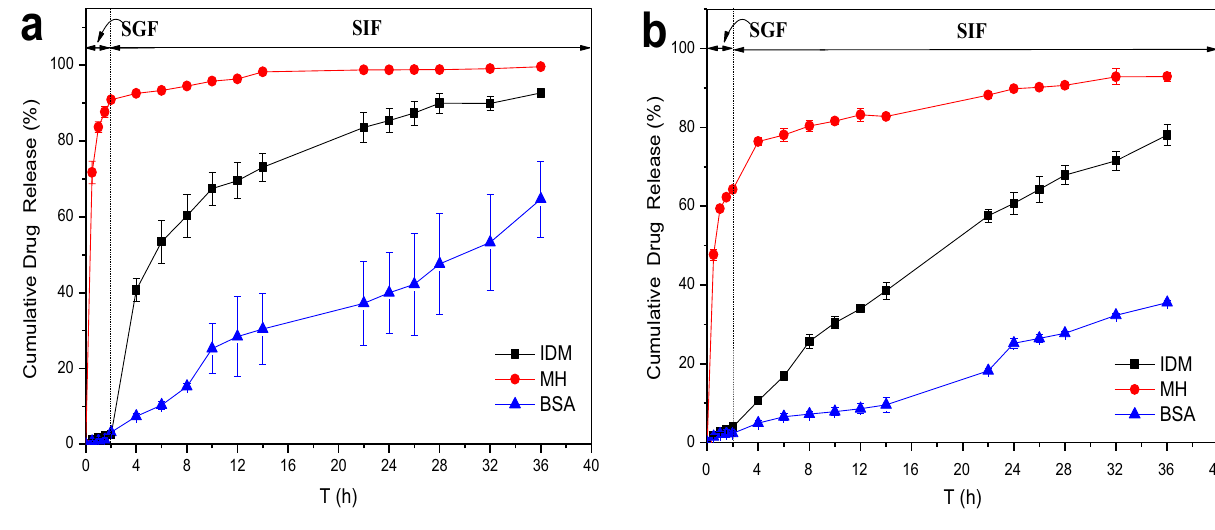
Figure 9. Effect of outer layer thickness on the cumulative drug release behavior of double layer hydrogels in simulated gastrointestinal fluid [( a ) SA-CMC@PDMA-2, external layer formation time: 1 min; ( b ) SA-CMC@ PDMA-3, external layer formation time: 2 min].